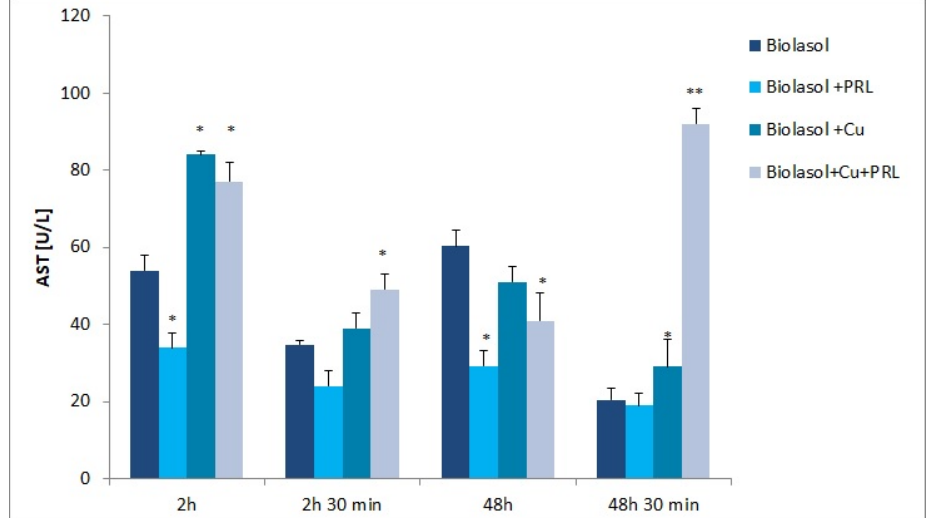
Figure 2. AST activity in collected perfusate samples. The values are expressed as mean ± SEM. Data were analysed by one-way ANOVA and Bonferroni post hoc tests; n = 10; * p < 0.05; ** p < 0.01 compared to the control group (Biolasol).